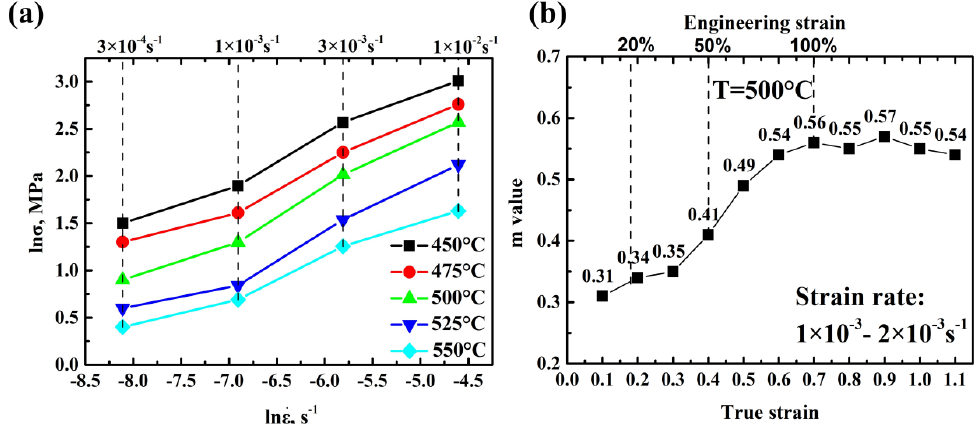
Figure 7. ( a ) The curves of ln σ vs. lnε in the temperature range of 450–550 °C, at strain rates ranging from 3 × 10 −4 to 1 × 10 −2 s −1 ; ( b ) the changing trend of the strain rate sensitivity of the superplastic flow, m values, against the strain within the strain rate range of 1 × 10 −3 ~2 × 10 −3 s −1 .